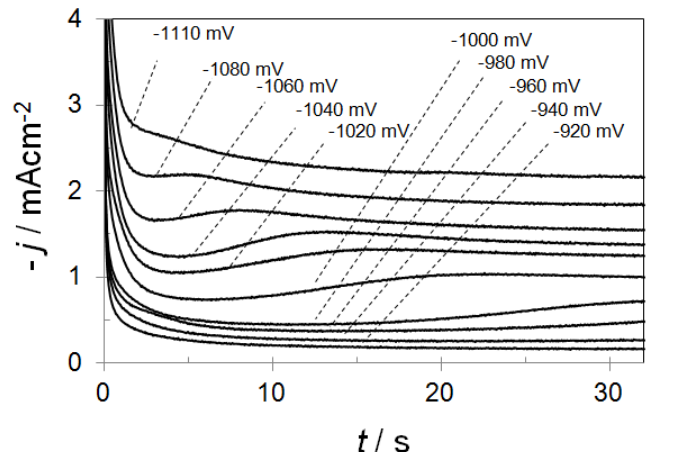
+ 1 M (NH ) SO at pH=7 on a polycrystalline gold by using 4 4 2 4